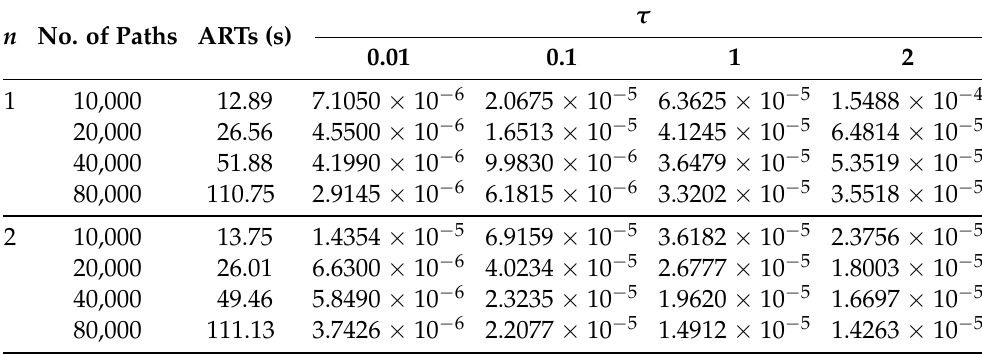
Table 1. The mean absolute error E (cid:104) n (cid:105) ( τ ) of U and τ = 0.01,0.1,1,2.